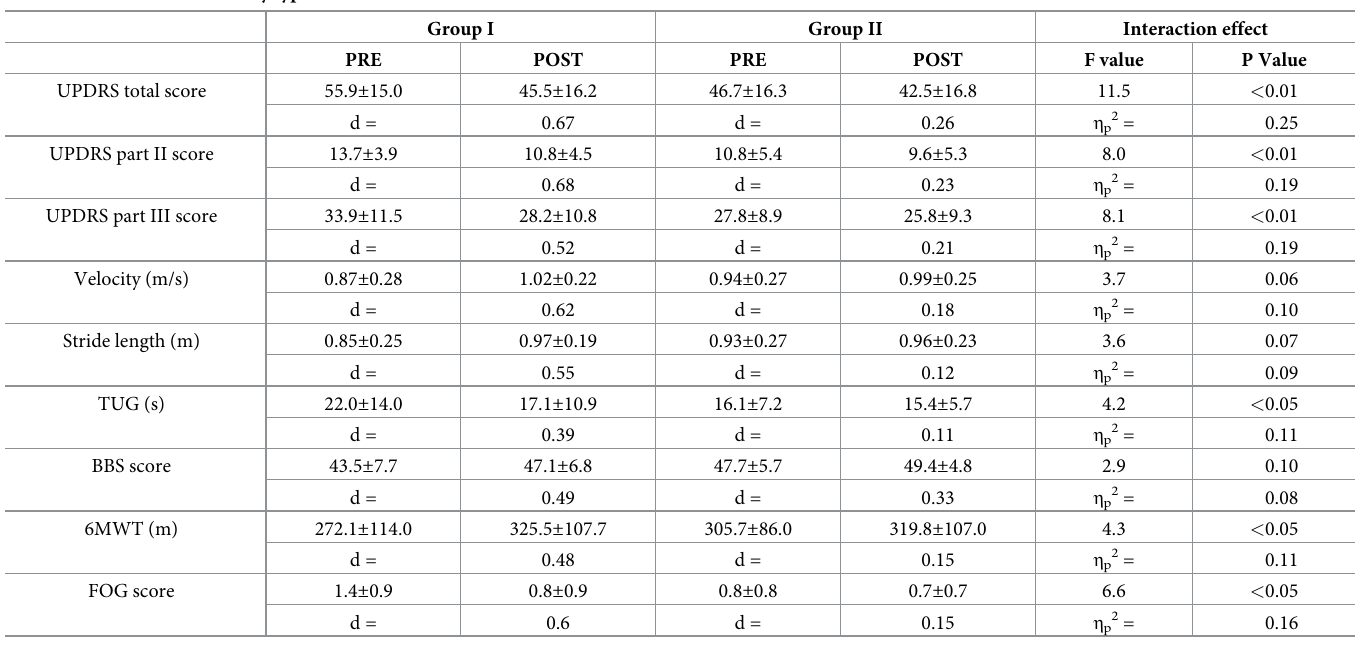
Table 2. Functional outcome by type of rehabilitation.